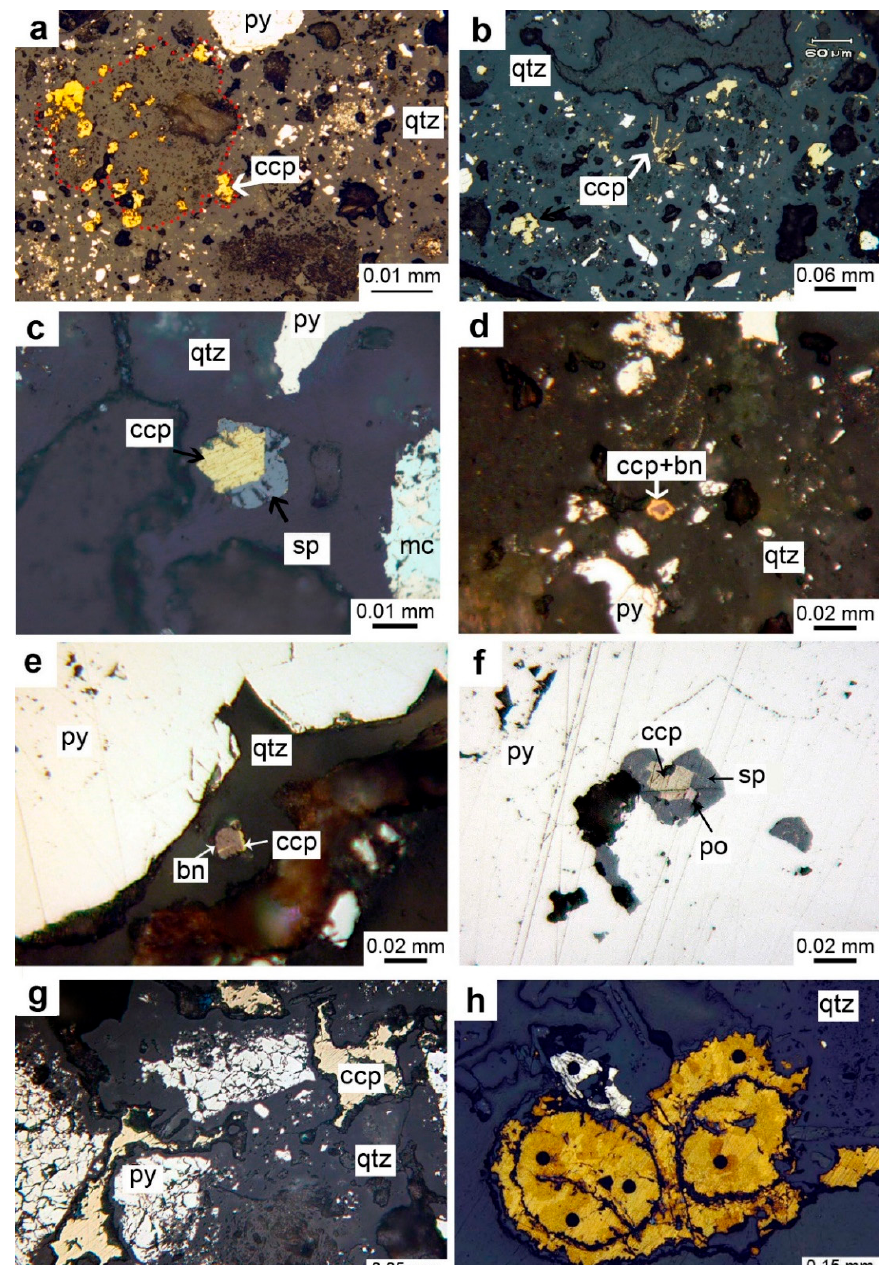
Figure 6. Morphological varieties of chalcopyrite and bornite in sulfide breccias from the Semenov-3 hydrothermal field: ( a ) chalcopyrite crystals inside the volcanic clast (emphasized by red dots) and the matrix; ( b ) radial aggregate of acicular chalcopyrite crystals in quartz; ( c ) fragmented crystalline chalcopyrite overgrown by sphalerite crystal; ( d ) small bornite grain with chalcopyrite rim inside quartz; ( e ) bornite grain with chalcopyrite lamella and rim; ( f ) pyrrhotite–chalcopyrite–sphalerite assemblage in crystalline pyrite; ( g ) anhedral chalcopyrite aggregates in quartz; ( h ) reniform chalcopyrite after radial marcasite aggregate (etched by vapors of a HNO 3 + HCl mixture; black dots are areas of LA-ICP-MS analysis).